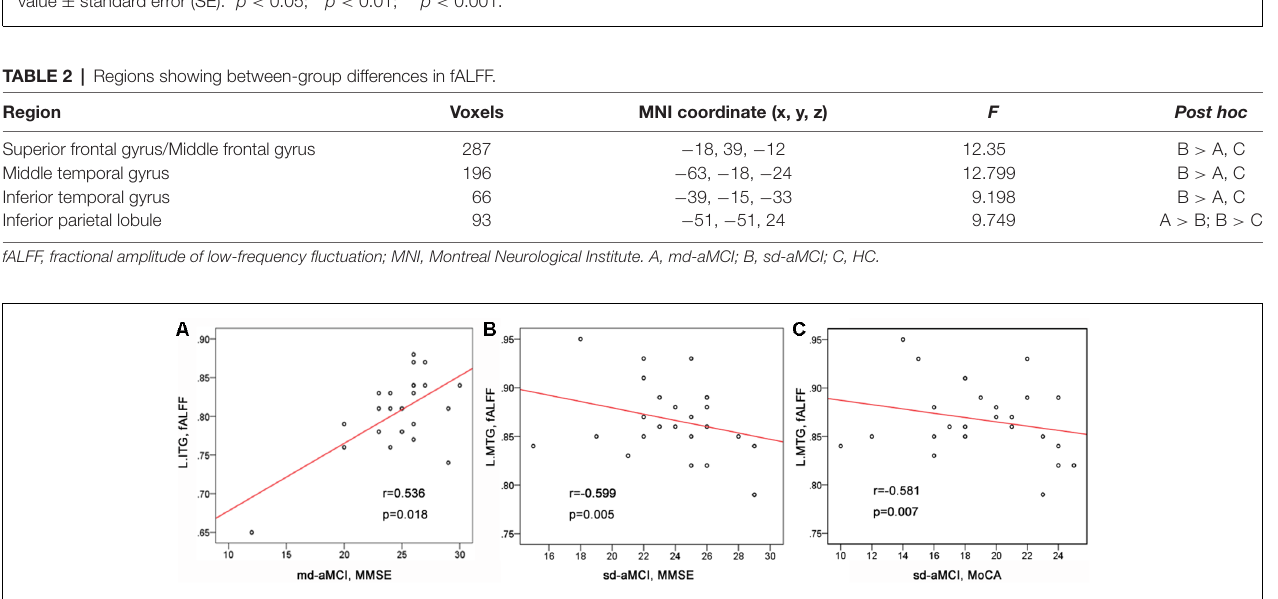
FIGURE 2 | The correlations between the fALFF values and cognitive scores. (A) Significant positive correlations between the fALFF of the left inferior temporal gyrus and the mini-mental state examination (MMSE) scores found within the md-Amnestic mild cognitive impairment (aMCI) group. (B,C) Significant negative correlations between the fALFF of the left middle temporal gyrus and the MMSE scores, between the fALFF of the left middle temporal gyrus and the MoCA scores found within the single-domain-aMCI (sd-aMCI)